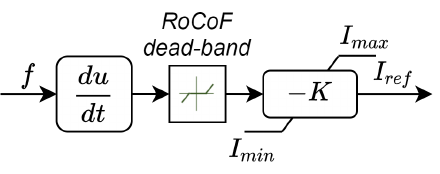
Figure 5. Block diagram of the SI controller simulated with the